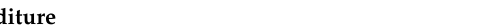
Table 3. Estimation of metabolic energy spent on activities during the production process. (Level colour code: Green : Light; Yellow : Moderate; Orange :